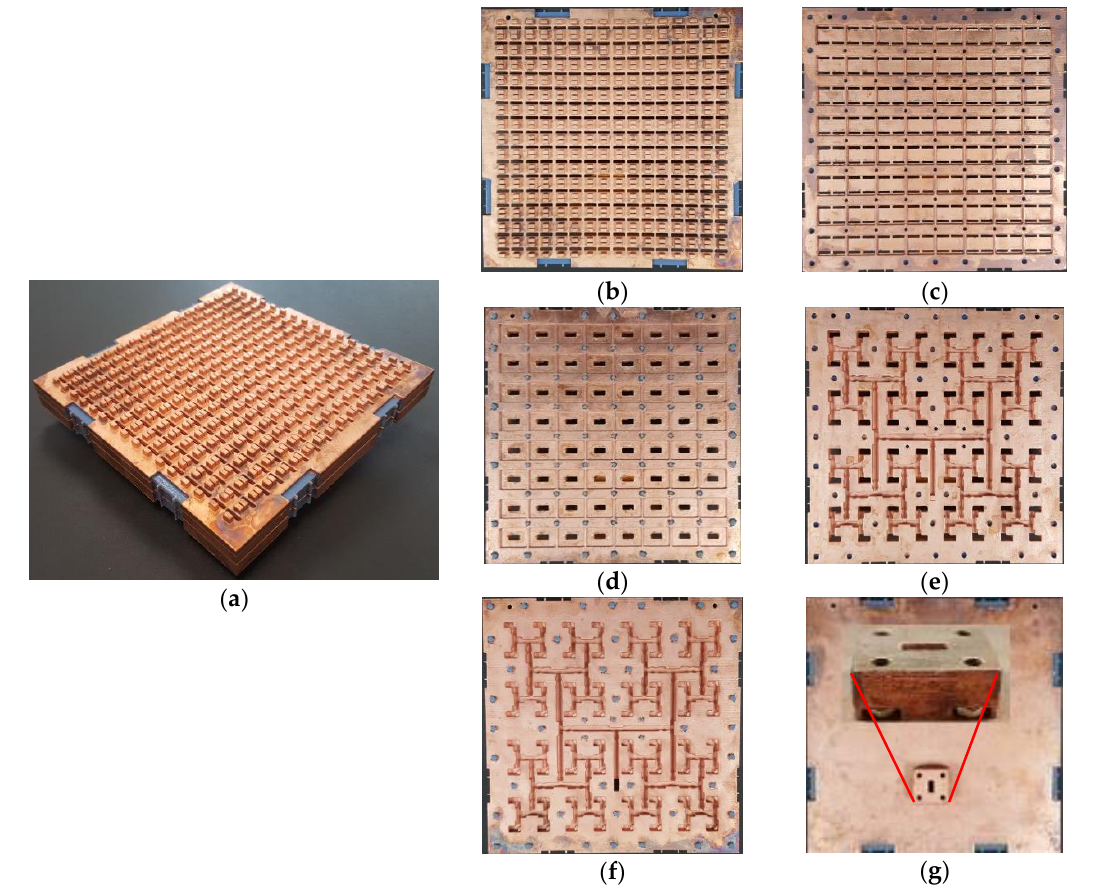
Figure 2. Prototype of the 3D printed 16 × 16 complementary dipole antenna array: ( a ) 3D view; ( b ) top view of first layer; ( c ) bottom view of first layer; ( d ) top view of second layer; ( e ) bottom view of second layer; ( f ) top view of third layer; ( g ) bottom view of third layer.